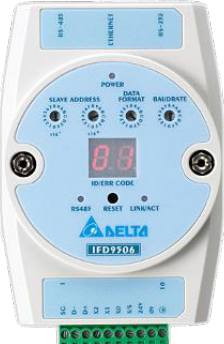
Figure 7. Connection of WattNode to the server via an RS485-to-TCP/IP converter.